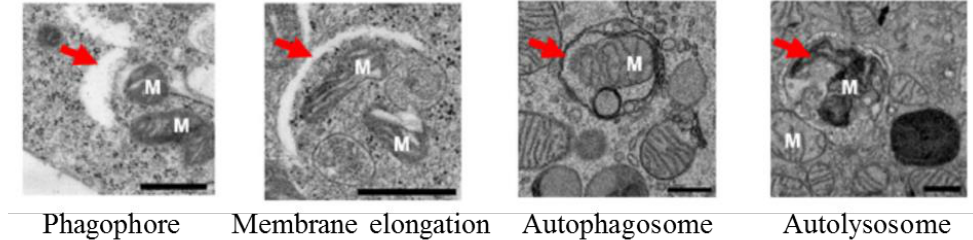
Figure 3. Macroautophagy process under electron microscopy. Red arrows are indicating the phagophore, membrane elongation, autophagosome, and autolysosome. M: mitochondria, scale bar: 500 nm. Adapted from [60].